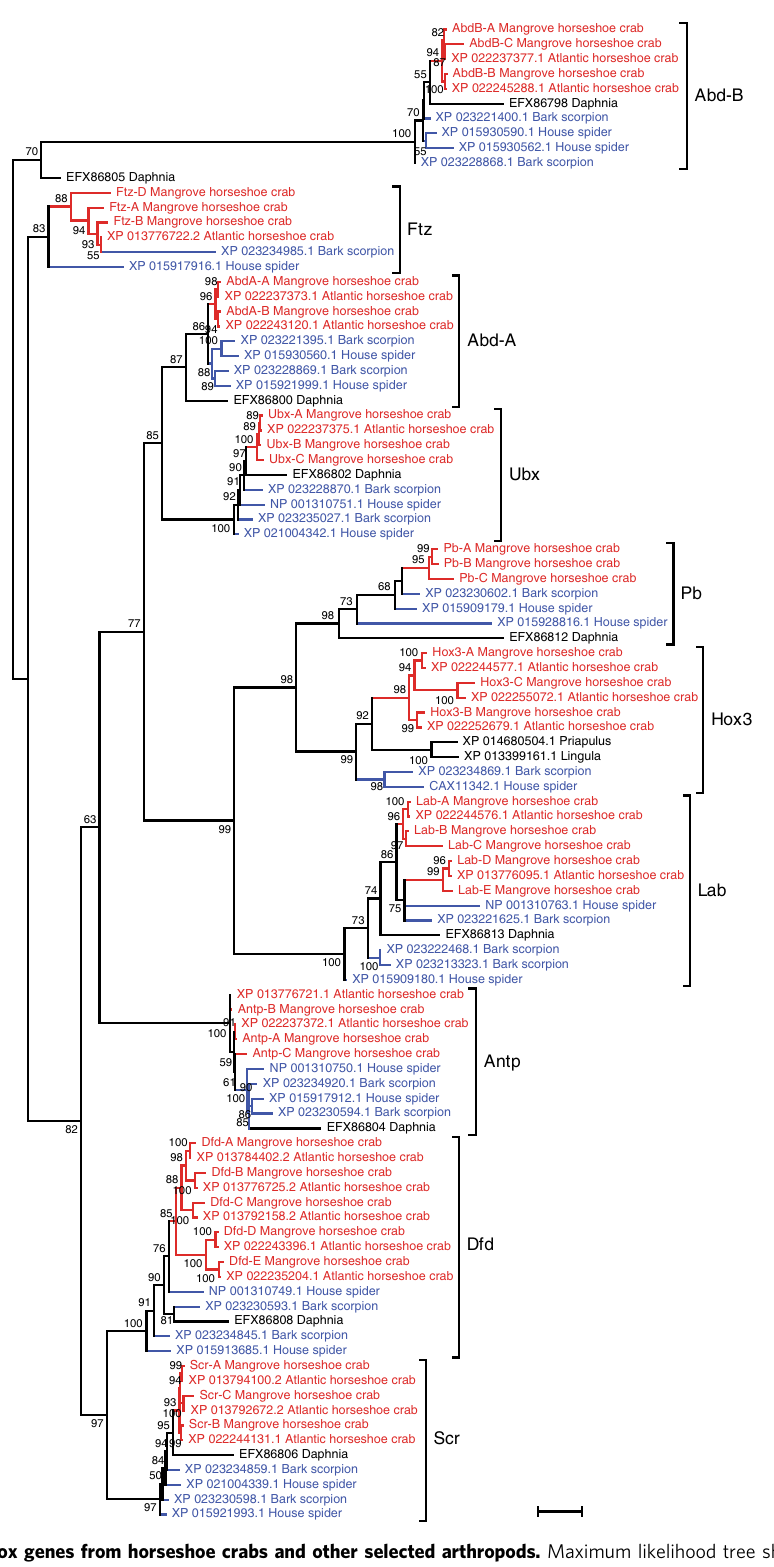
Fig. 4 Phylogenetic tree of Hox genes from horseshoe crabs and other selected arthropods. Maximum likelihood tree showing the phylogenetic relationship of Hox genes from horseshoe crabs (red font), spider and scorpion (blue font) and outgroup species (black font). Values at the nodes represent bootstrap support percentages. The scale bar denotes one substitution per